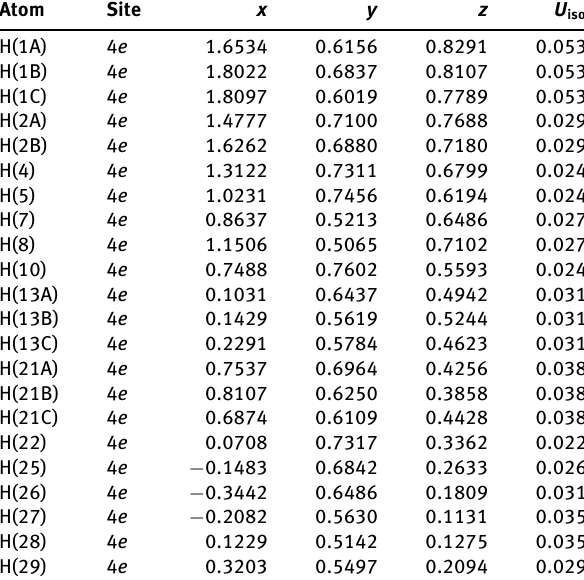
H3.95%.Thetitlecompoundcrystallizedfromhexaneatroom temperature. Upon irradiation with 297 nm light, the colorless single- crystals of the title structure turn blue quickly. When the